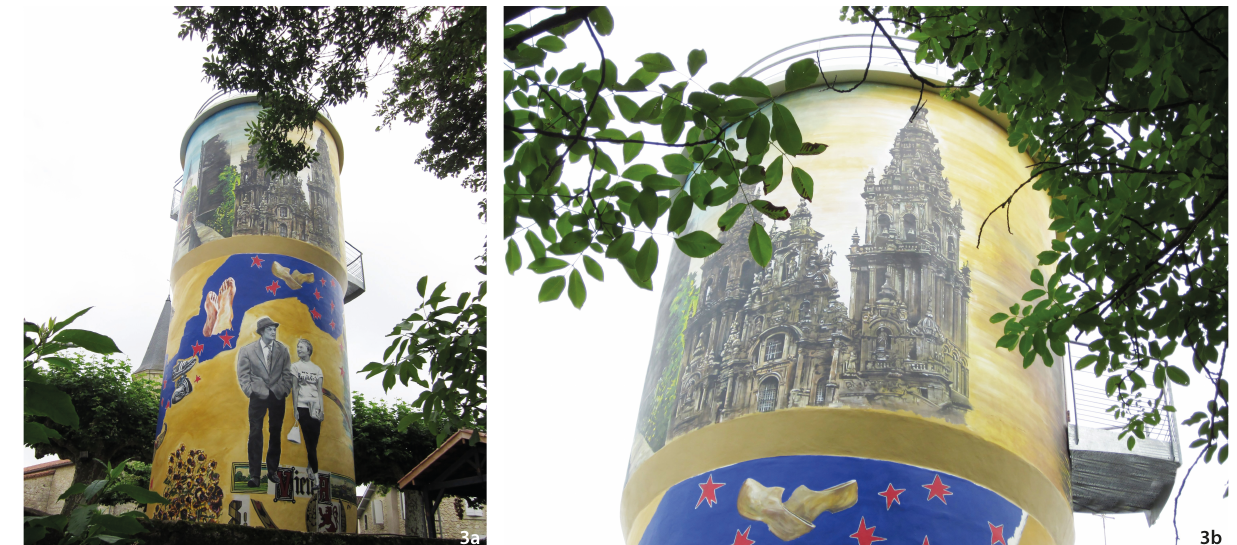
Figure 3 Water tower after the rehabilitation (Source: the